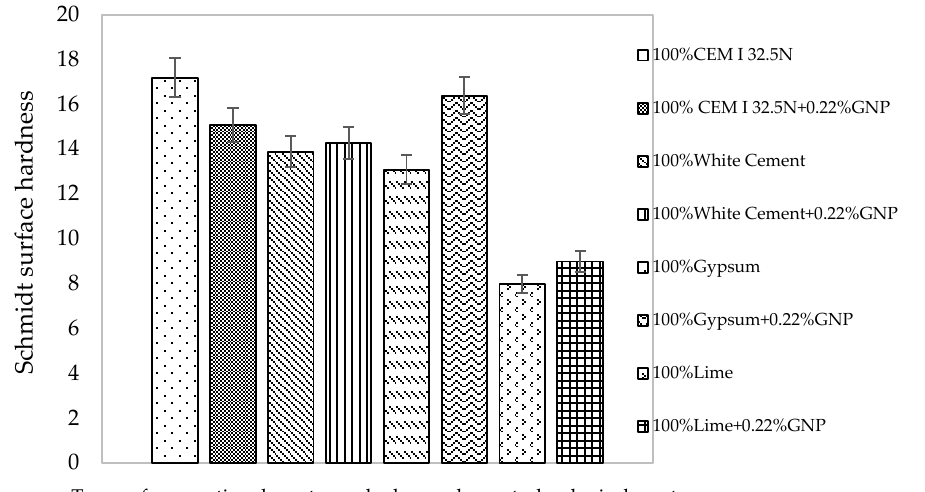
Figure 6. Changes in the Schmidt surface hardness of the various types of mortars and the binder type, binder percent, supplement type, and supplement percent.